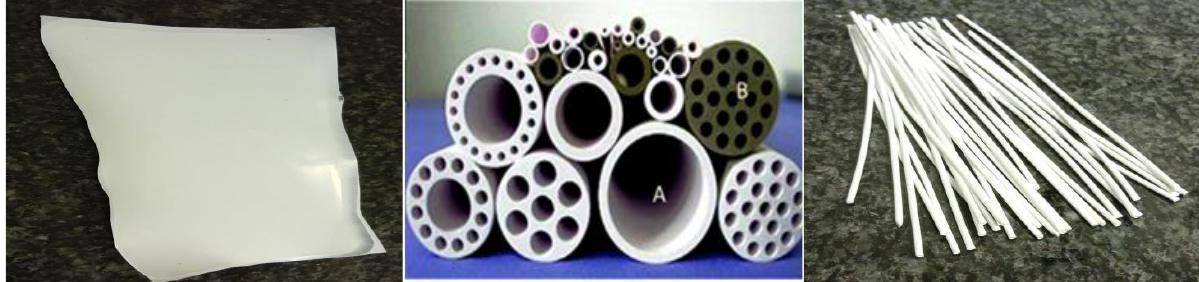
Figure 5. Different membrane configurations: flat sheet membrane was produced by authors of this study ( left ); hollow membranes ( center ). A — tubular hollow membrane; B — multichannel monolithic hollow membrane, reproduced with permission from [13], Copyright 2016 Elsevier. Hollow fiber membranes were internally produced ( right ).